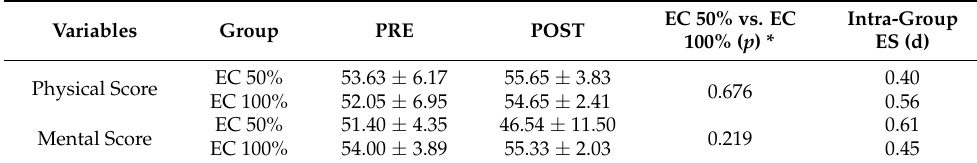
Table 5. Results of Quality of Life.